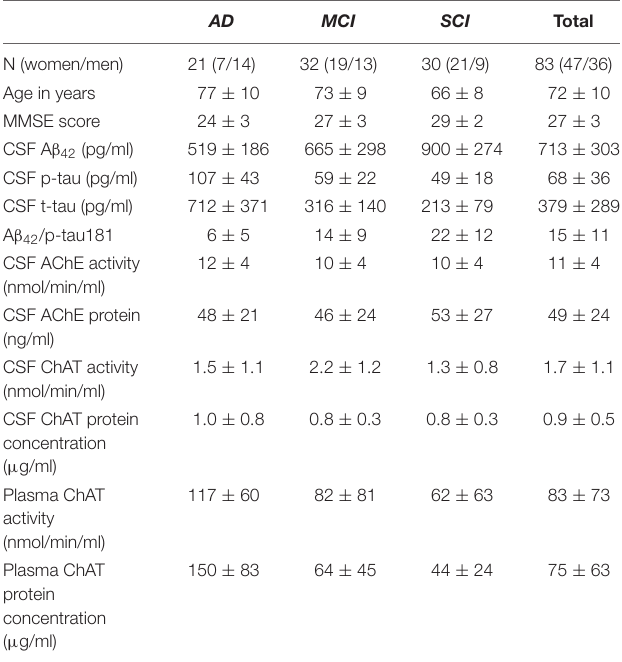
TABLE 1 | Demographic data overview and measured levels of relevant biomarkers in CSF and